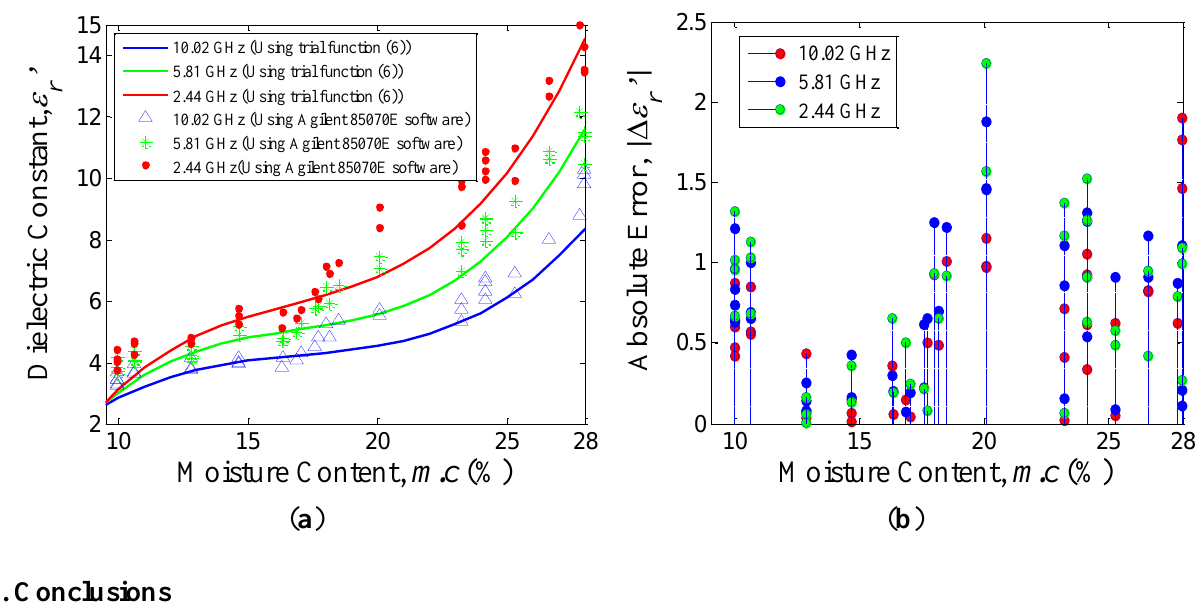
Figure 7. ( a ) The variations in of single rice grain with its bulk moisture content, m.c. at 2.44 GHz, 5.81 GHz and 10.02 GHz, respectively. ( b ) The absolute deviation, |Δ | of dielectric constant prediction between the use of studied inversion technique and the Agilent 85070E software